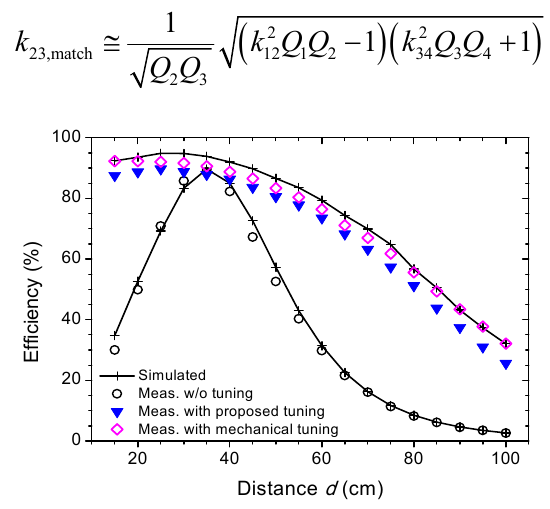
Figure 13. Efficiency comparison with and without a matching